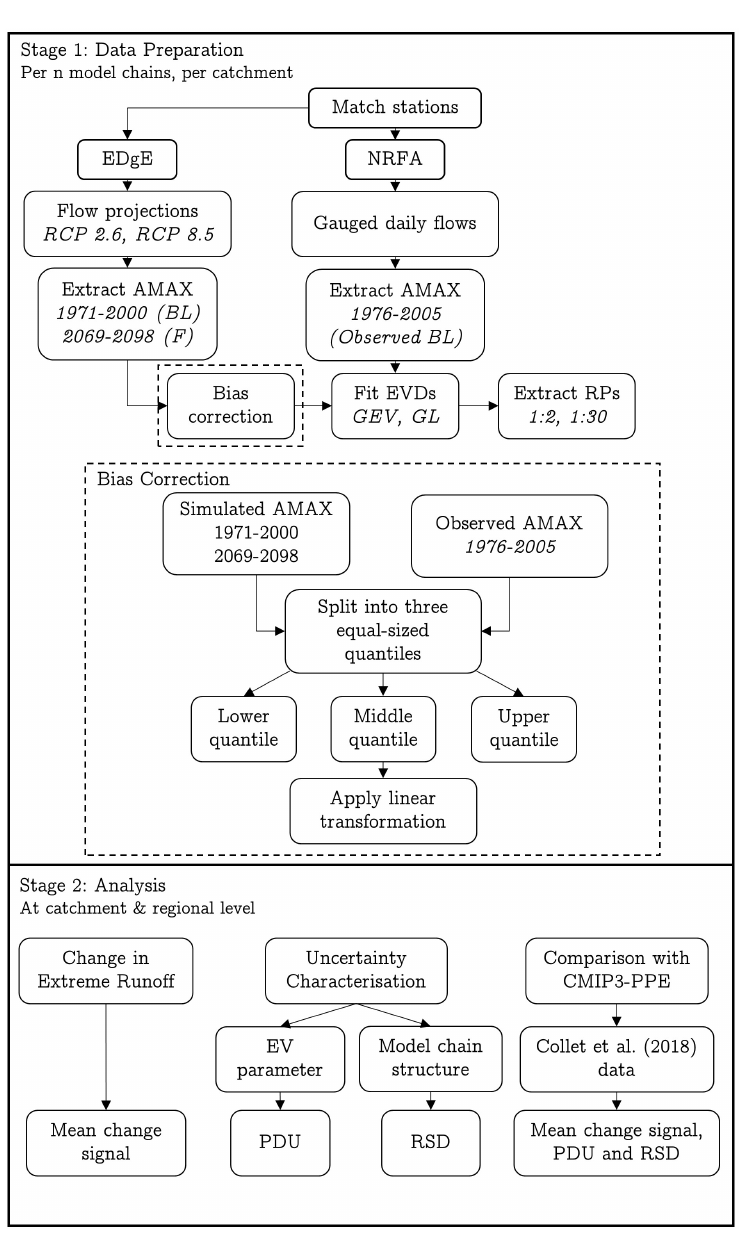
Figure 2. Outline of the methodology utilised in this work. It is split into two distinct stages: data preparation (Stage 1) and analysis (Stage